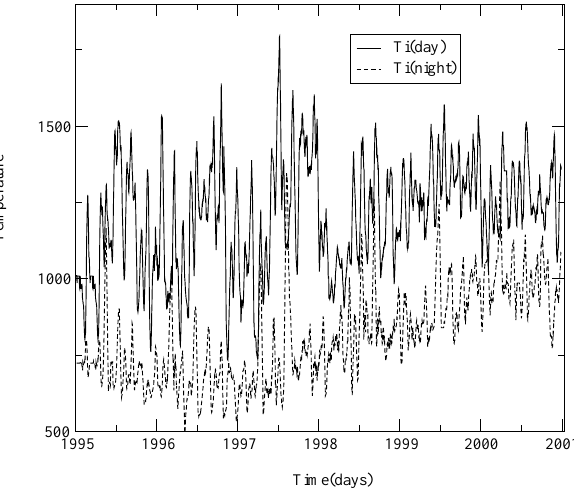
Fig. 2. Daytime (full line) and nighttime (dotted lines) average val- ues of ion temperature during